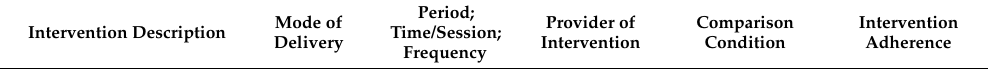
Table 2. Characteristics of physical activity interventions implemented in studies on people living with HIV aged 50 years or